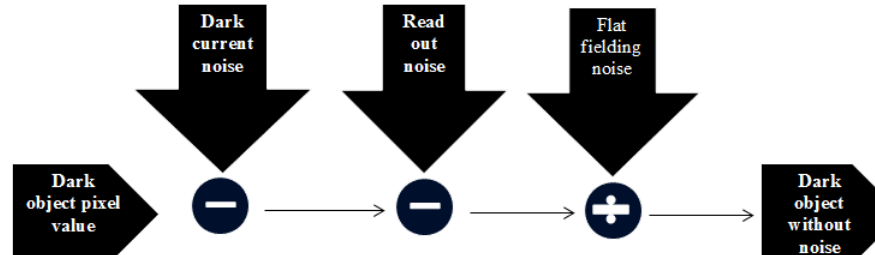
Fig. 3. Removal algorithms for dark current noise, read noise and flat-field from dark object